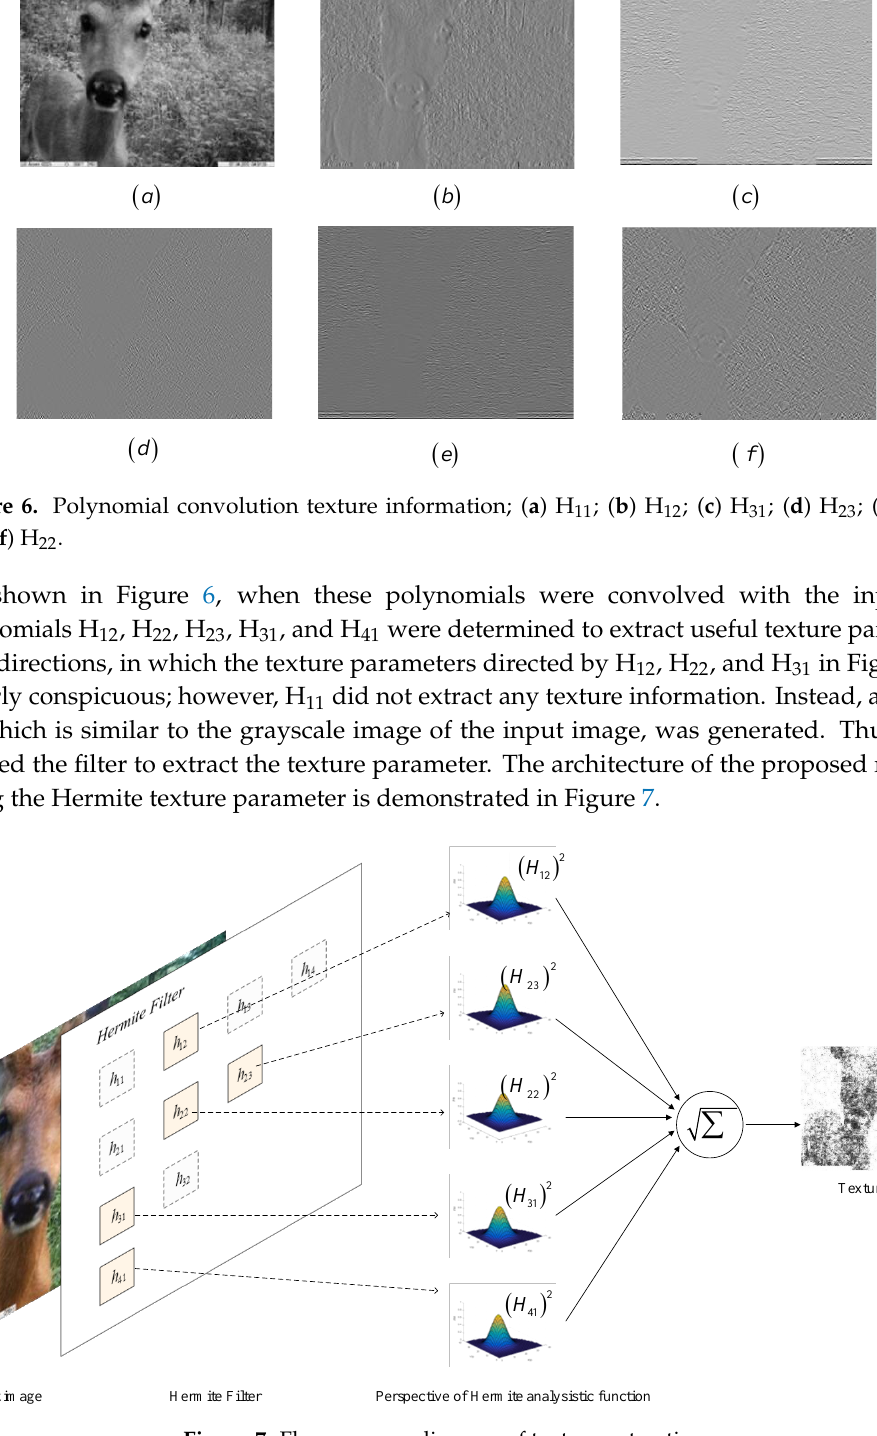
Figure 7. Flow-process diagram of texture extraction.